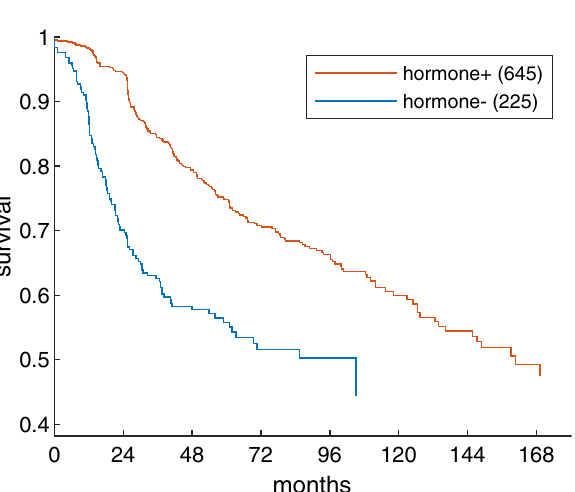
Figure 4. Survival free from recurrence for hormone status. Hormon status is considered positive, if either ER or PGR are positive, otherwise negative. Kaplan Meier estimates of survival free from recurrence for 870 patients (who had rfs-data) for different hormone receptor status. Log-rank test p =